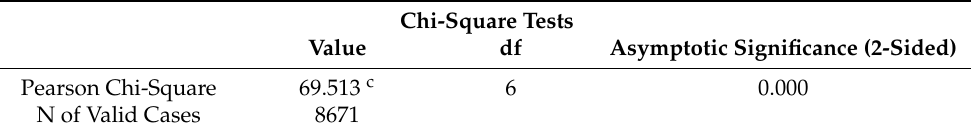
Table 11. Chi-square test (enterprise size vs. change in the ROA 2021 profitability indicator). Source: own research.